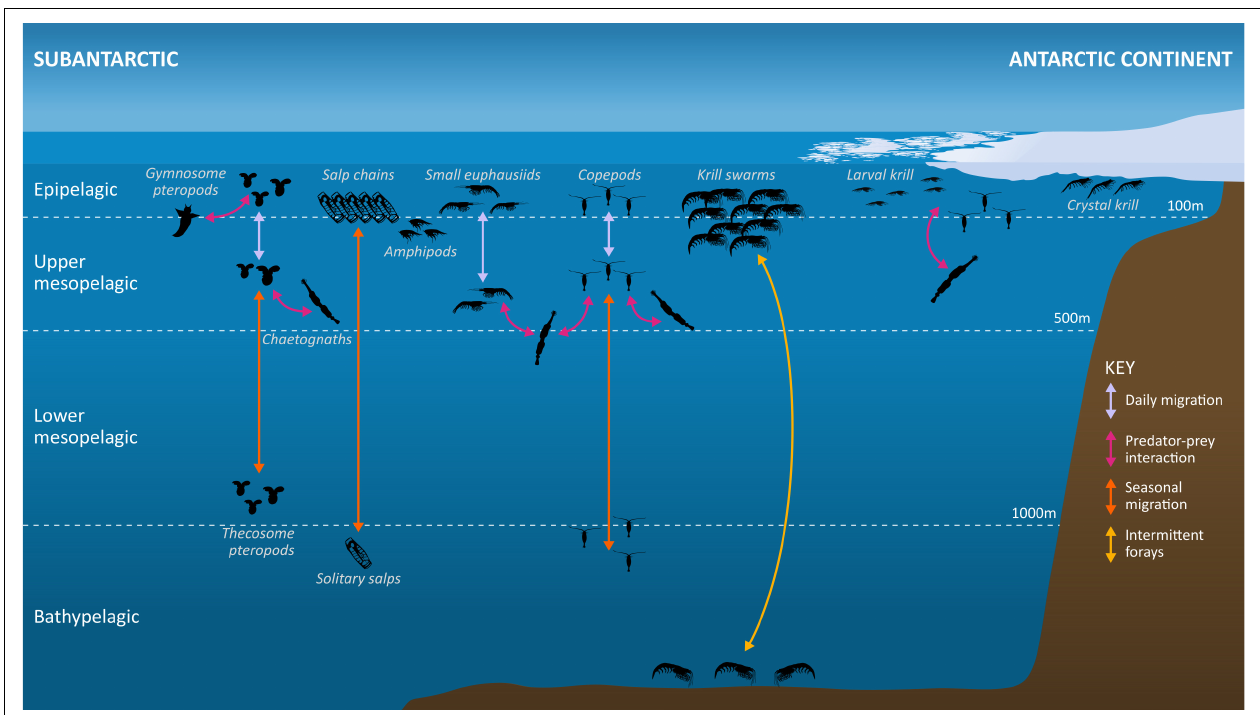
FIGURE 3 | Metazoan zooplankton occupy a range of habitats throughout the Southern Ocean, from the continent to the subantarctic islands, from the surface waters to the deep ocean, and in association with sea ice. They migrate vertically over daily and/or seasonal timescales. Several species of euphausiids, copepods, salps and pteropods are notable for their biomass and importance in maintaining Southern Ocean food webs and ecosystem structure and functioning, including as key consumers and prey items in supporting benthic communities and predator populations, and in biogeochemical cycles and carbon budgets. A number are also important in the diets of fish, marine mammals and seabirds that underpin wildlife tourism and commercially exploited fish species (Antarctic toothfish, Patagonian toothfish, and mackerel icefish), while Antarctic krill ( Euphausia superba ) is the direct target of harvesting operations. Not illustrated (for clarity) are a variety of other detritivorous or carnivorous groups, for example ostracods, cnidarians, appendicularians, polychaetes, decapods, etc., whose predominance increases with depth. We have illustrated chaetognaths as a major predator of the key taxa illustrated here, although many other taxa such as cnidarians and decapods also perform this function. Intermittent forays: performed by Antarctic krill to the seabed are carried out over a range of timescales from daily to